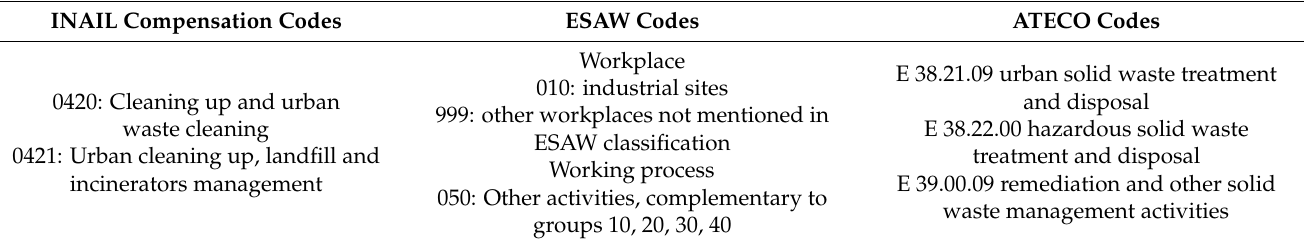
Table A1. ESAW, ATECO, and INAIL compensation codes used as data filters.